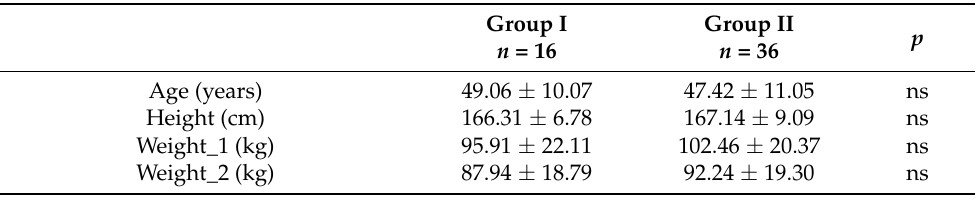
Table 3. Average values of anthropometric